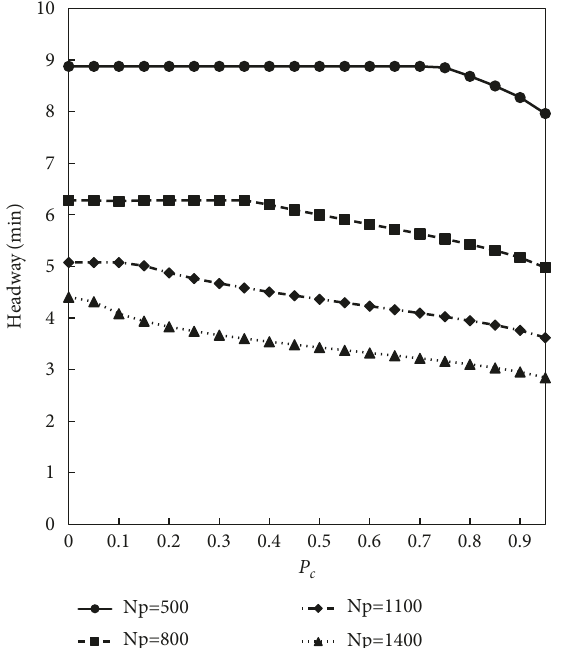
Figure 6: Optimal headway under different numbers of